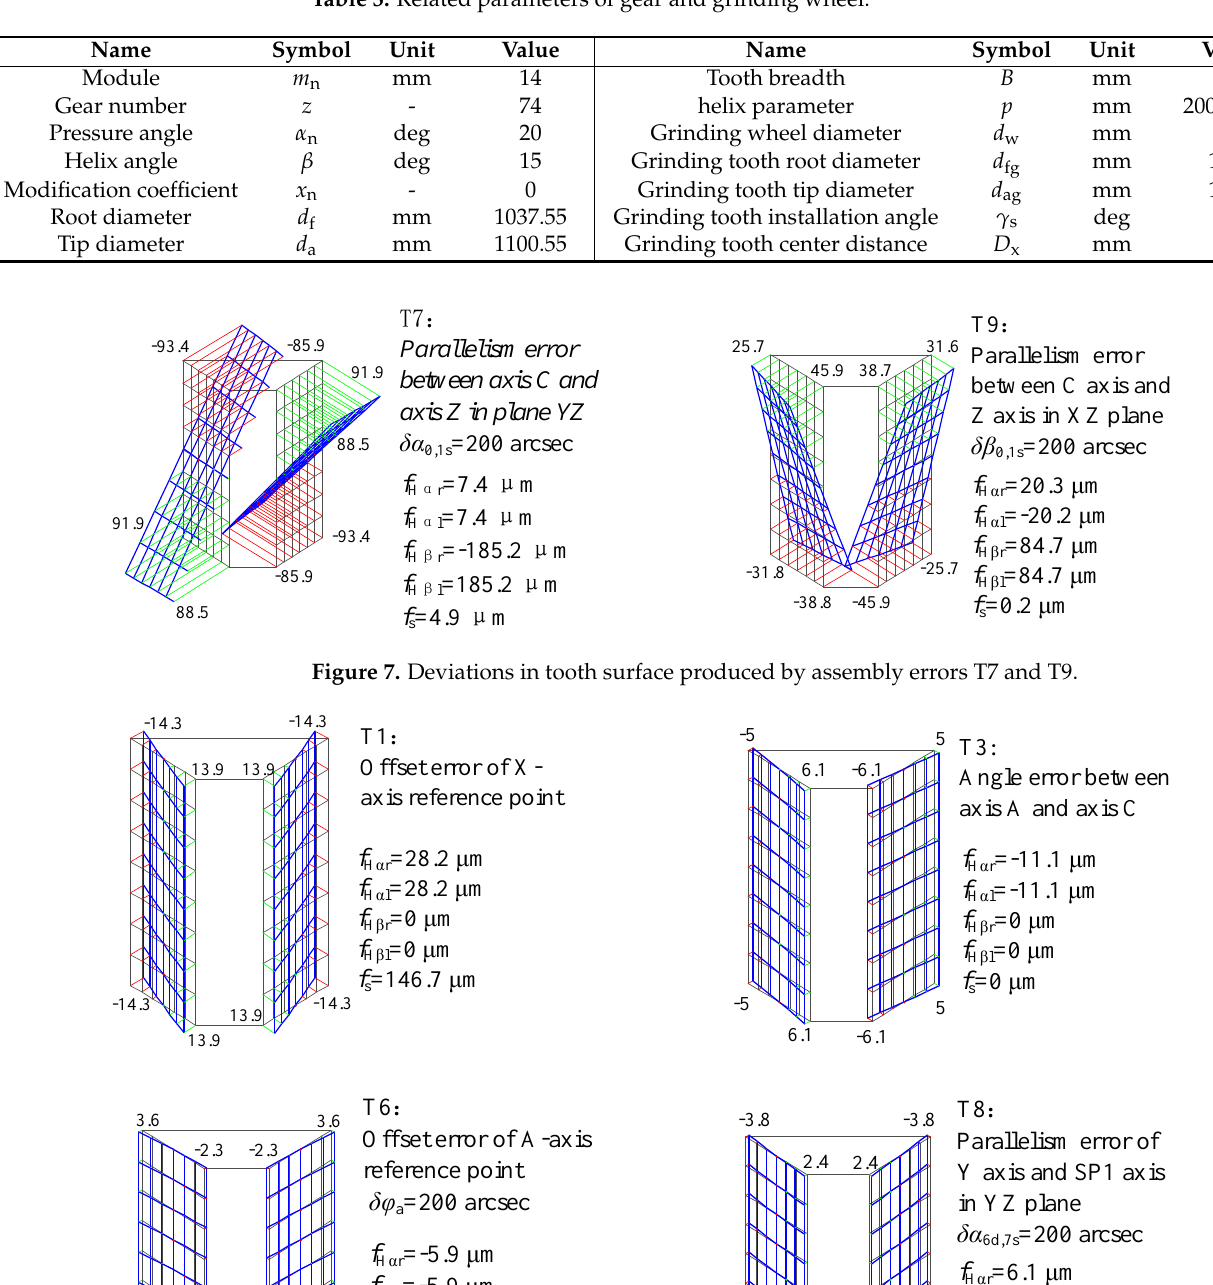
Table 3. Related parameters of gear and grinding wheel.